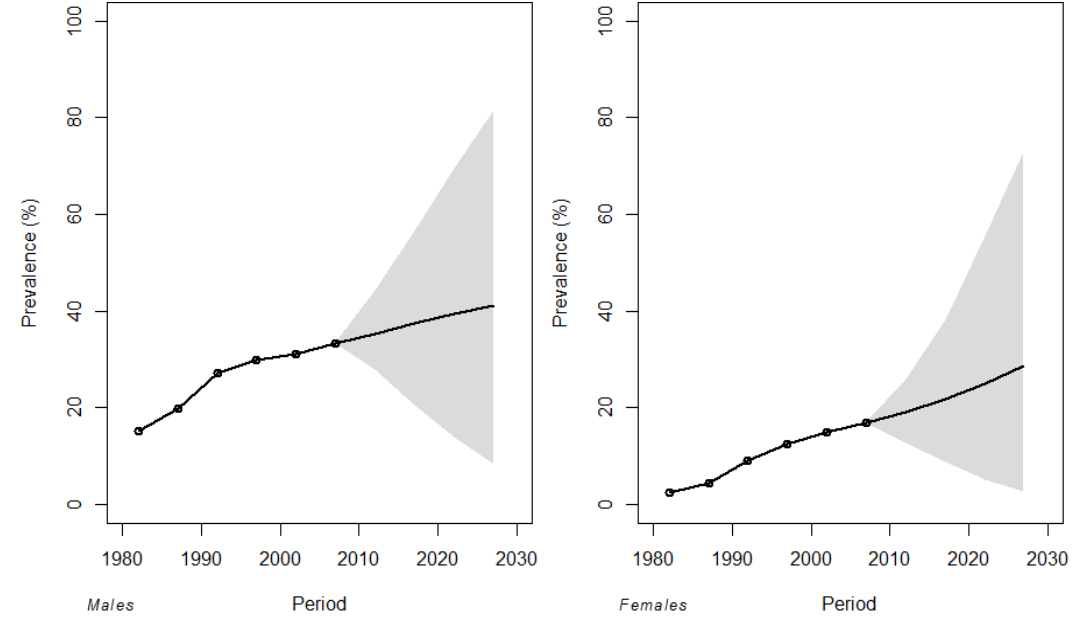
Figure 4. Fitted and projected prevalence of former smokers cumulated by age (25–85 years) with 95% credible intervals by period for males and females. Dots are the observed cumulated